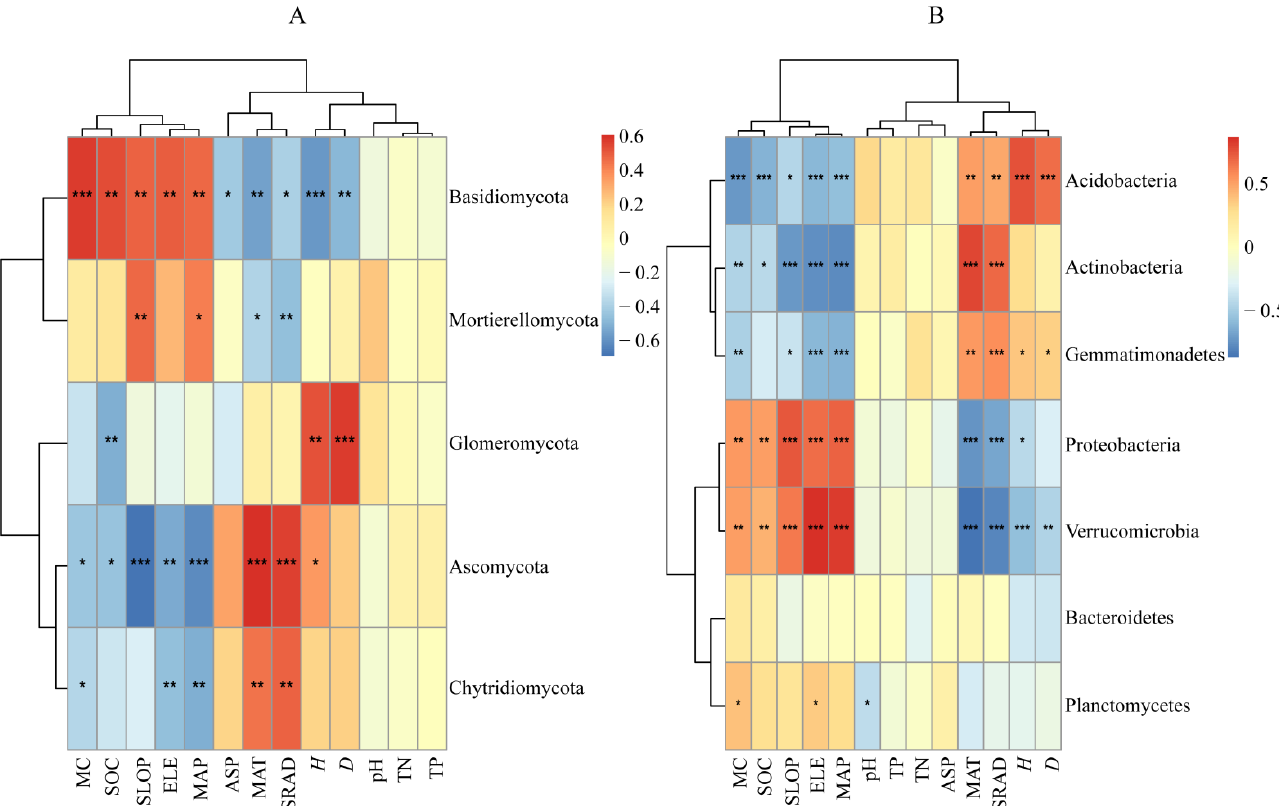
Figure 5. Heatmaps of soil fungi ( A ) and bacteria ( B ) vis-à-vis the environmental factors. Red represents positive correlations and blue represents negative correlations. MC, soil moisture content; TN, total nitrogen; TP, total phosphorus; SOC, soil organic carbon; ALT, elevation; MAP: average annual precipitation; SRAD, sun radiation; MAT, average annual temperature; ASP, aspect; SLOP, slope; H , Shannon–Wiener diversity; D , Margalef richness. Asterisks indicate significance level. Signif. Codes: p < 0.05 (*), p < 0.01 (**), p < 0.001 (***), p > 0.05 (blank).